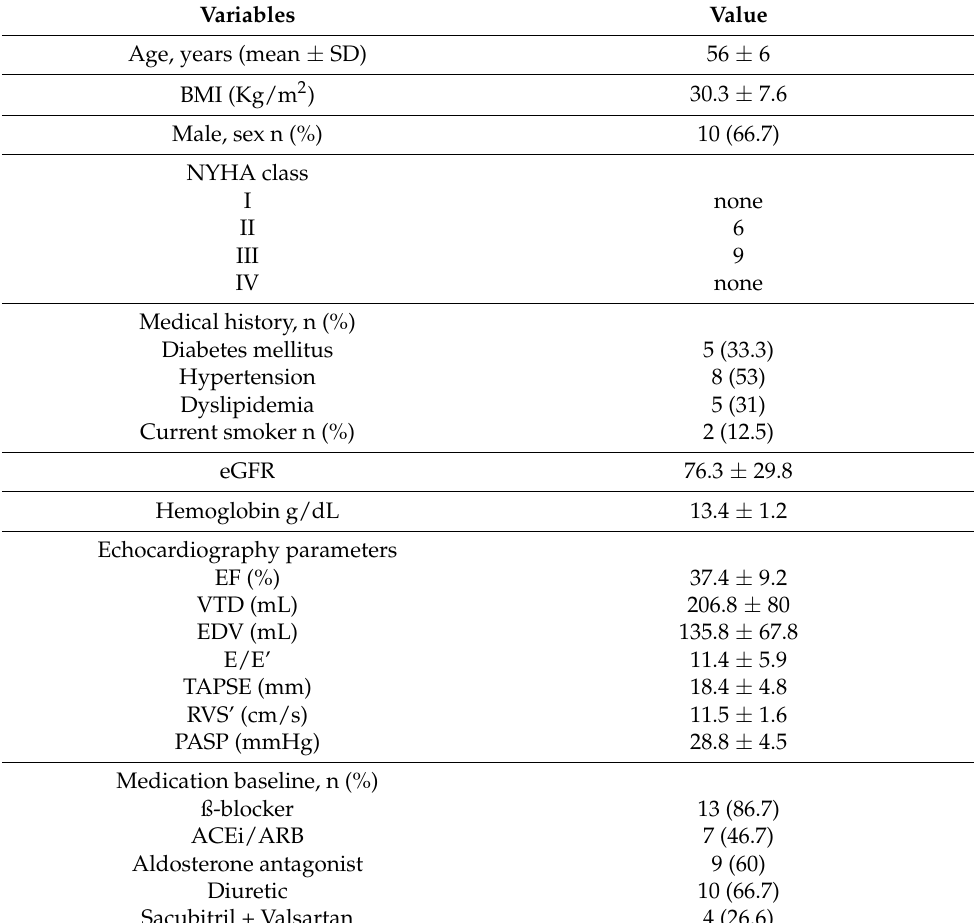
Table 1. Baseline characteristics of dilated cardiomyopathy